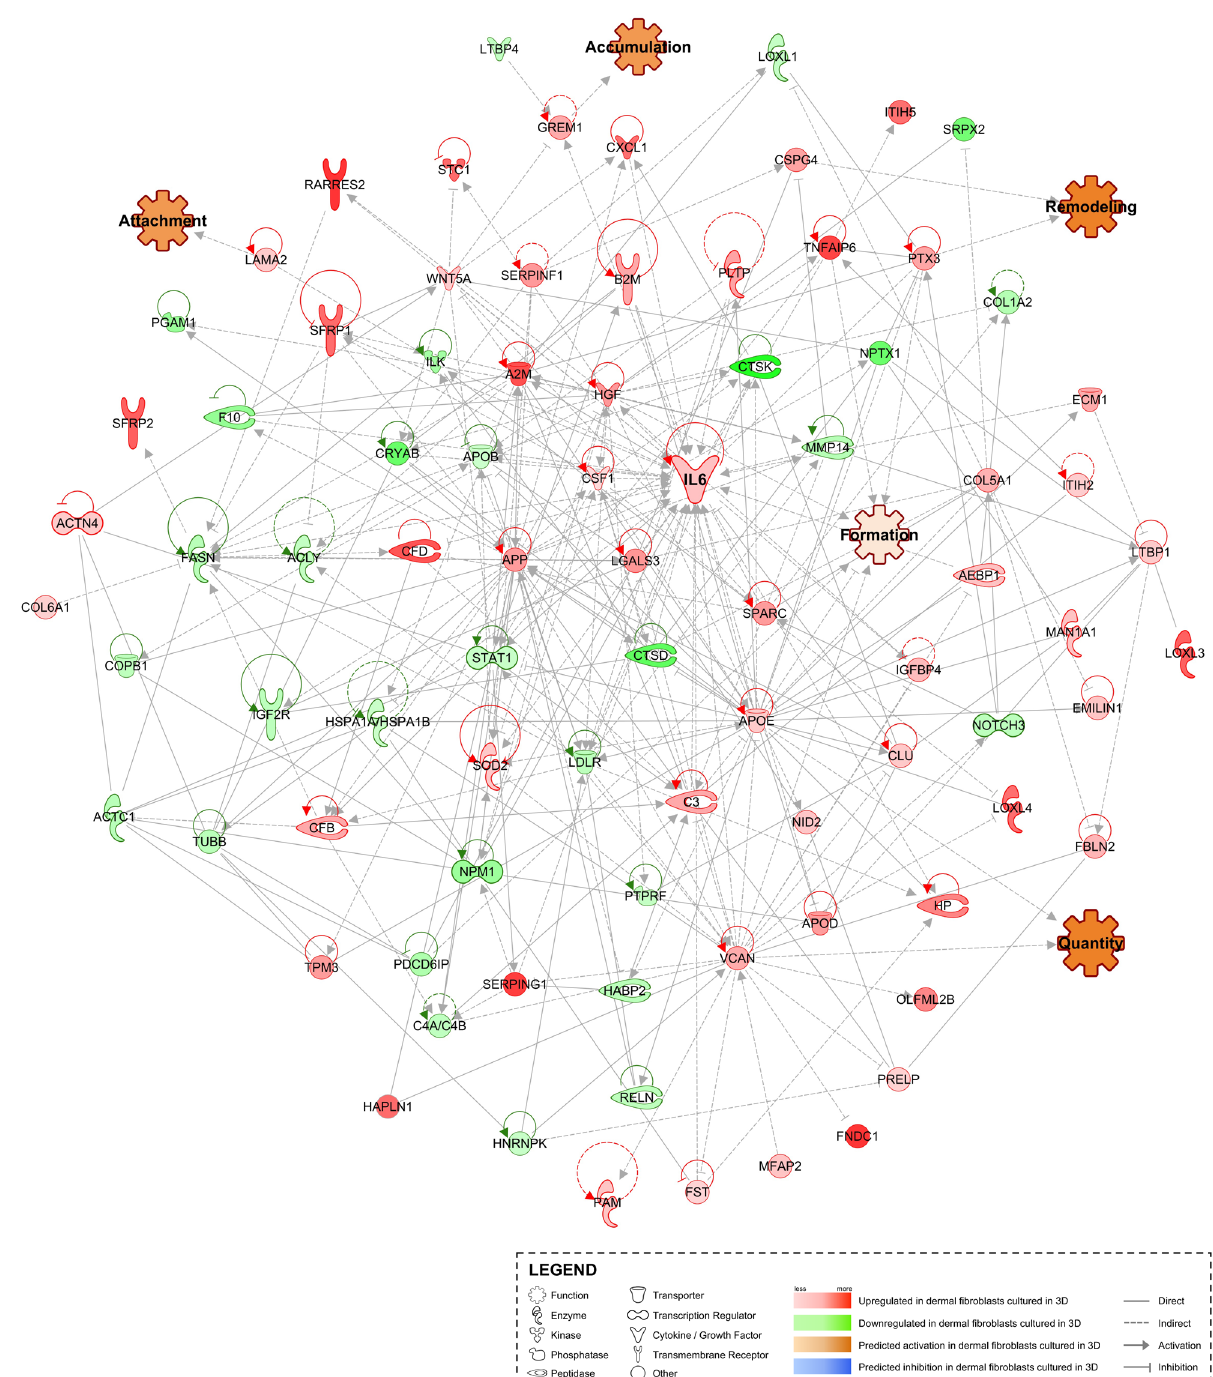
Figure 5. Interactome analysis of exosomal proteins isolated from exosomes secreted within 3D fibroblast culture media. Ingenuity Pathway Analysis generated interactome of significantly modulated exosomal proteins detected from 3D fibroblast cultures. Protein expression profiles predict the activation of functions associated with extracellular matrix, such as quantity, formation, attachment, accumulation and remodelling. The cytokine IL-6, which seems to be central to the signalling pathways, has been